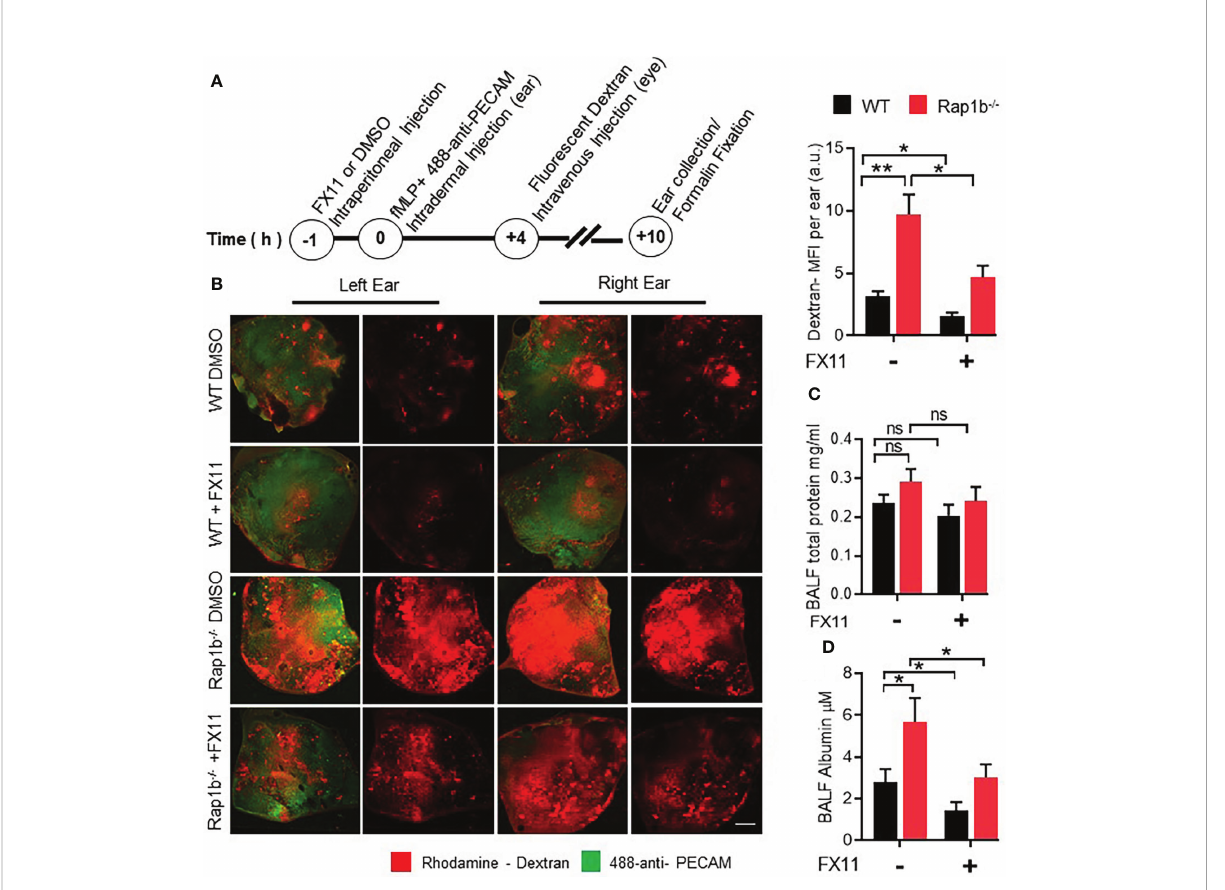
FIGURE 3 FX11 treatment decreases vascular leakage in vivo . (A) , Ear vascular leakage analysis in fMLP stimulated Rap1b -/- and WT mice ear. Timeline depicting vascular leakage model in mouse ear. (B) , Representative fl uorescent images of whole ear mount, showing amount of rhodamine dextran leakage following fMLP stimulation for 10 h in the presence or absence of Ldha-I. Bar graph showing quanti fi cation of total rhodamine dextran fl uorescence per ear, after 10 h of fMLP stimulation in the ear (n=4 mice each group; 2 independent experiments). (C, D) BAL fl uids were analyzed for vascular leakage after lungs were challenged with interstitial saline or LPS for 4 h in the presence or absence of Ldha-I in WT and Rap1b -/- mice. Bar graphs show concentration of total protein (C) and total albumin (D) , in BALF after LPS challenge (n=6 mice/condition; 3 independent experiments). Mean ± SEM, *P < 0.05; **P < 0.001; NS, Not Signi fi cant, using unpaired Student ’ s t test. Scale Bar (B)